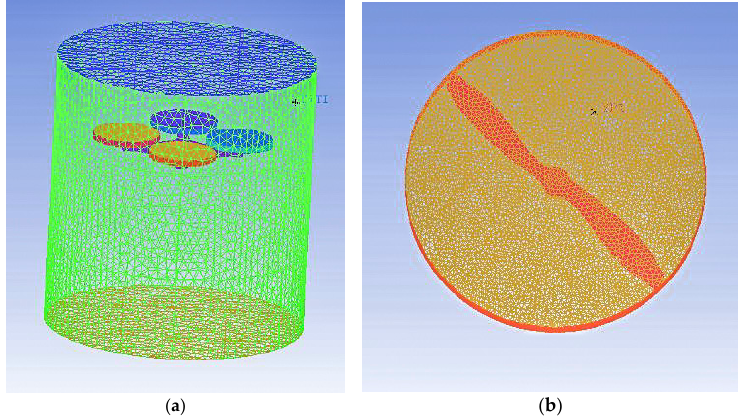
Figure 6. The grid divisions of the flow fields. ( a ) Grid division of the outer flow field; ( b ) Grid division of the inner flow field.